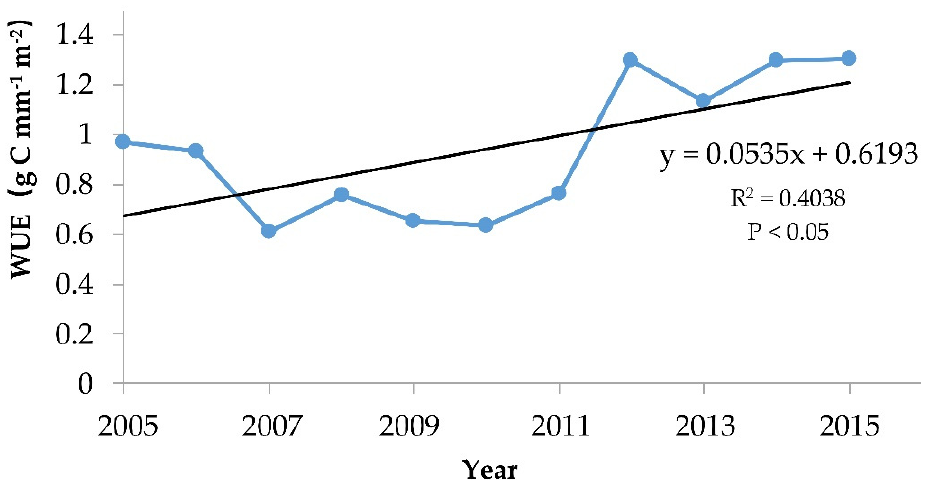
Figure 6. Temporal changes in the green space water use efficiency (WUE) in the Haihe River Basin.